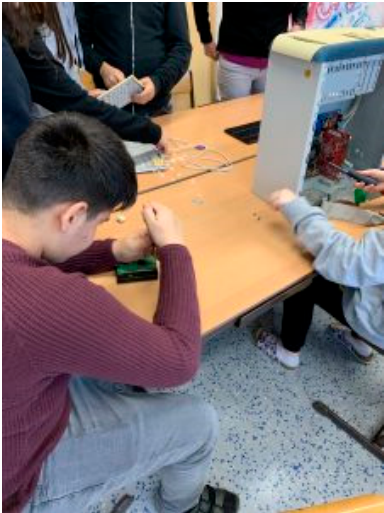
Figure 1. Disassembling an old computer to learn about its components.